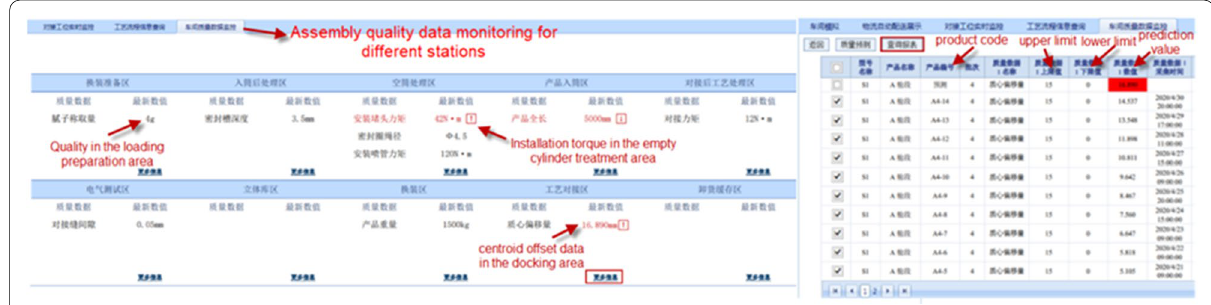
Figure 13 Interface for monitoring assembly quality data on the shop-floor